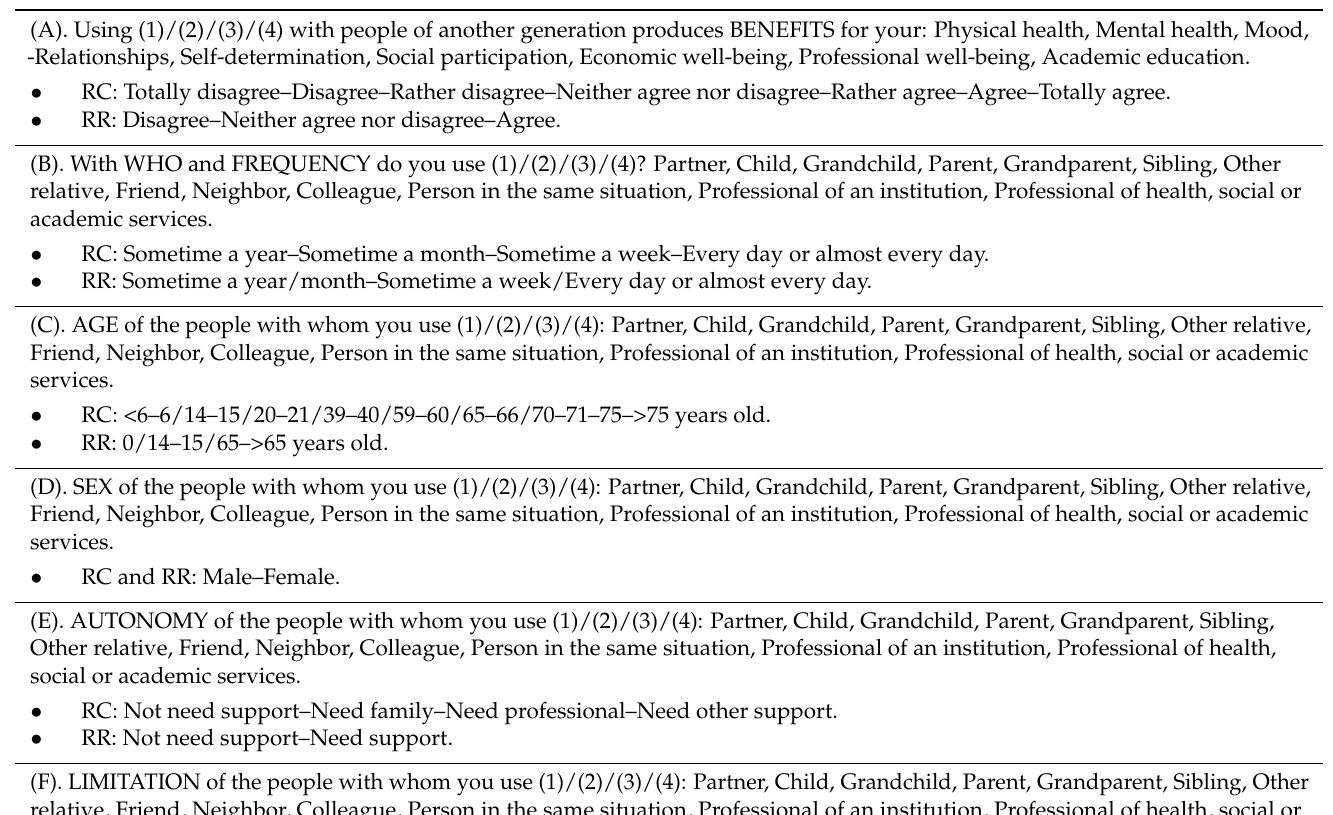
Table 1. Original coding and recoding of the answers of participants about the benefits of performing virtual activities using (1), (2), (3), or (4), on several categories: (A). Benefit; (B). People with whom and frequency; (C). Age; (D). Sex; (E) Autonomy; (F). Limitations; and (G). Satisfaction with whom they carry out those